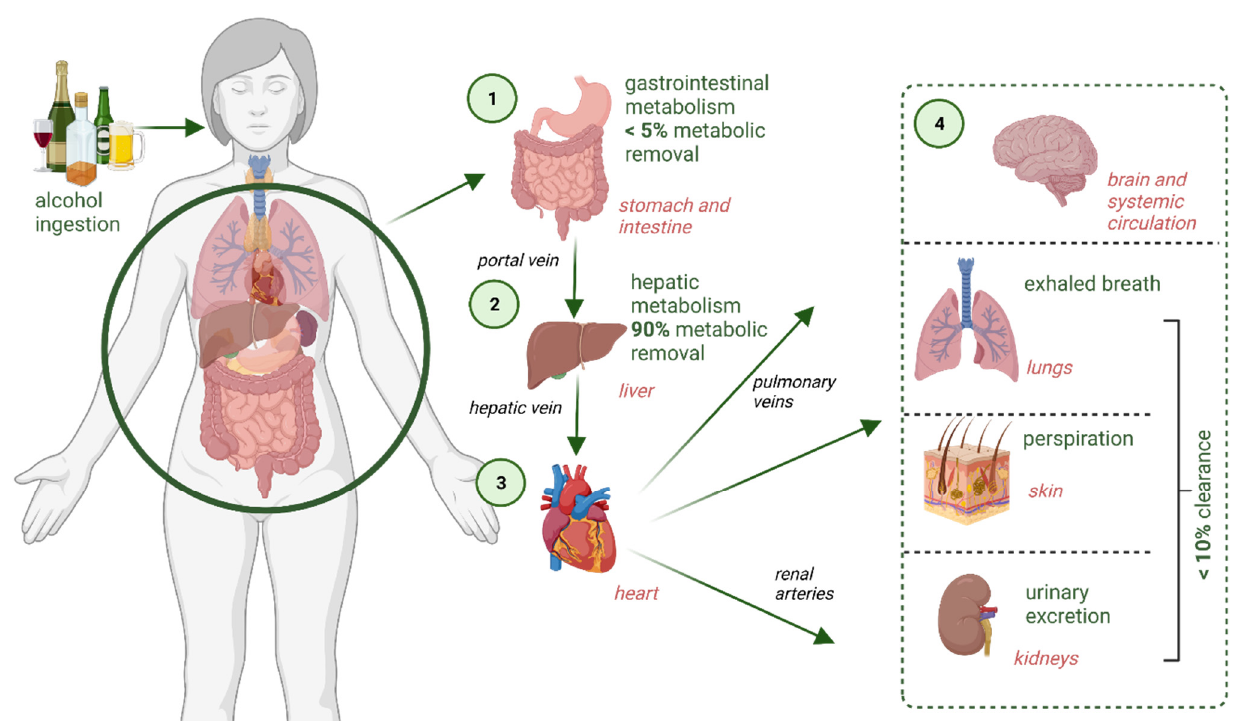
Figure 6. Alcohol (ethanol) disposition in the body. Only a small fraction (<10%) is eliminated unchanged through exhaled breath, perspiration and urinary excretion. Created with BioRender.com.